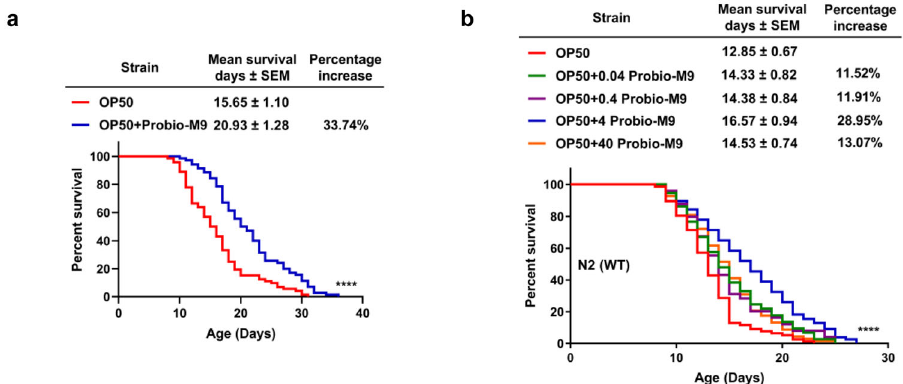
Fig. 1 Effects of Probio-M9 feeding on regulation of lifespan in C. elegans . a Probio-M9 precipitate was resuspended in OP50 signi fi cantly extended the lifespan of wild-type N2 worms ( p < 0.0001, Log rank test). b The most suitable dose of Probio-M9 (OP50 + 4 Probio-M9) signi fi cantly extended the lifespan of wild-type N2 worms ( p < 0.0001, Log rank test). The lower (OP50 + 0.04 Probio-M9 and OP50 + 0.4 Probio-M9) or higher (OP50 + 40 Probio-M9) amount of Probio-M9 exhibits less extension on lifespan ( p < 0.05, Log rank test). In a and b , lifespans were determined at least in three biologically independent experiments, and 90 worms of OP50 or OP50 + Probio-M9 feeding were tested in the single experiment, result from a single representative experiment is shown. The amount of OP50 and Probio-M9 which were used is 6.8 × 10 8 CFU/mL and 2.82 × 10 9